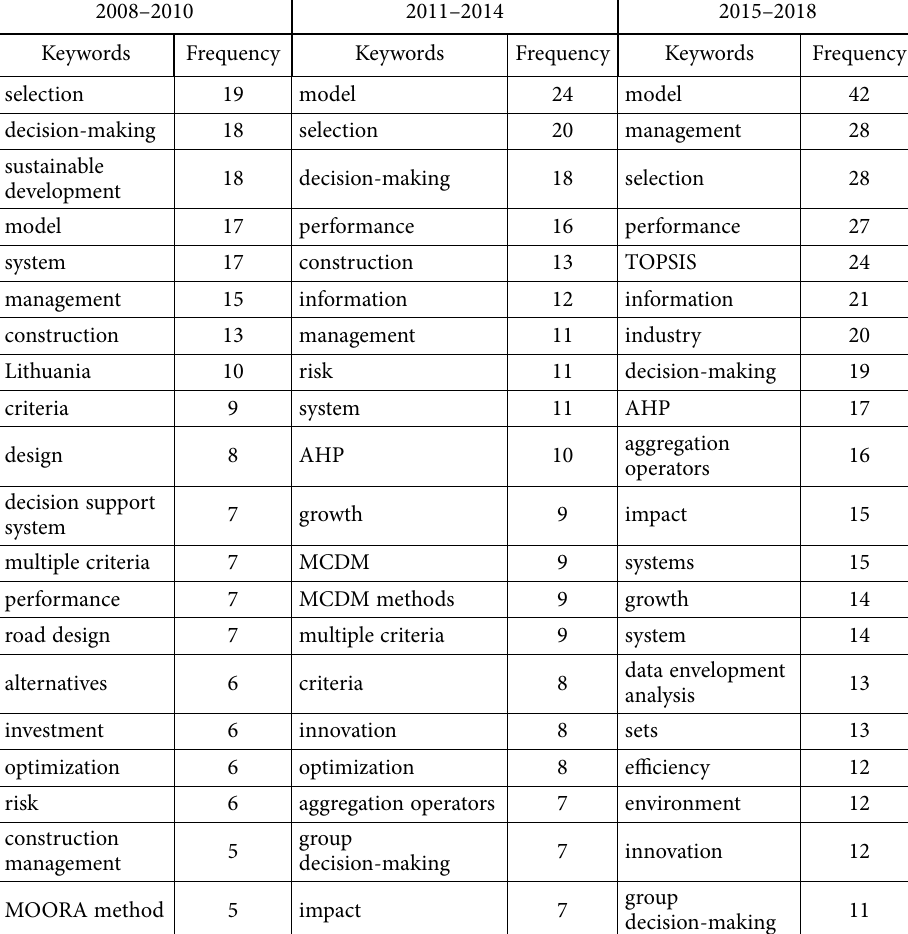
Table 8. Top 20 keywords used in three different